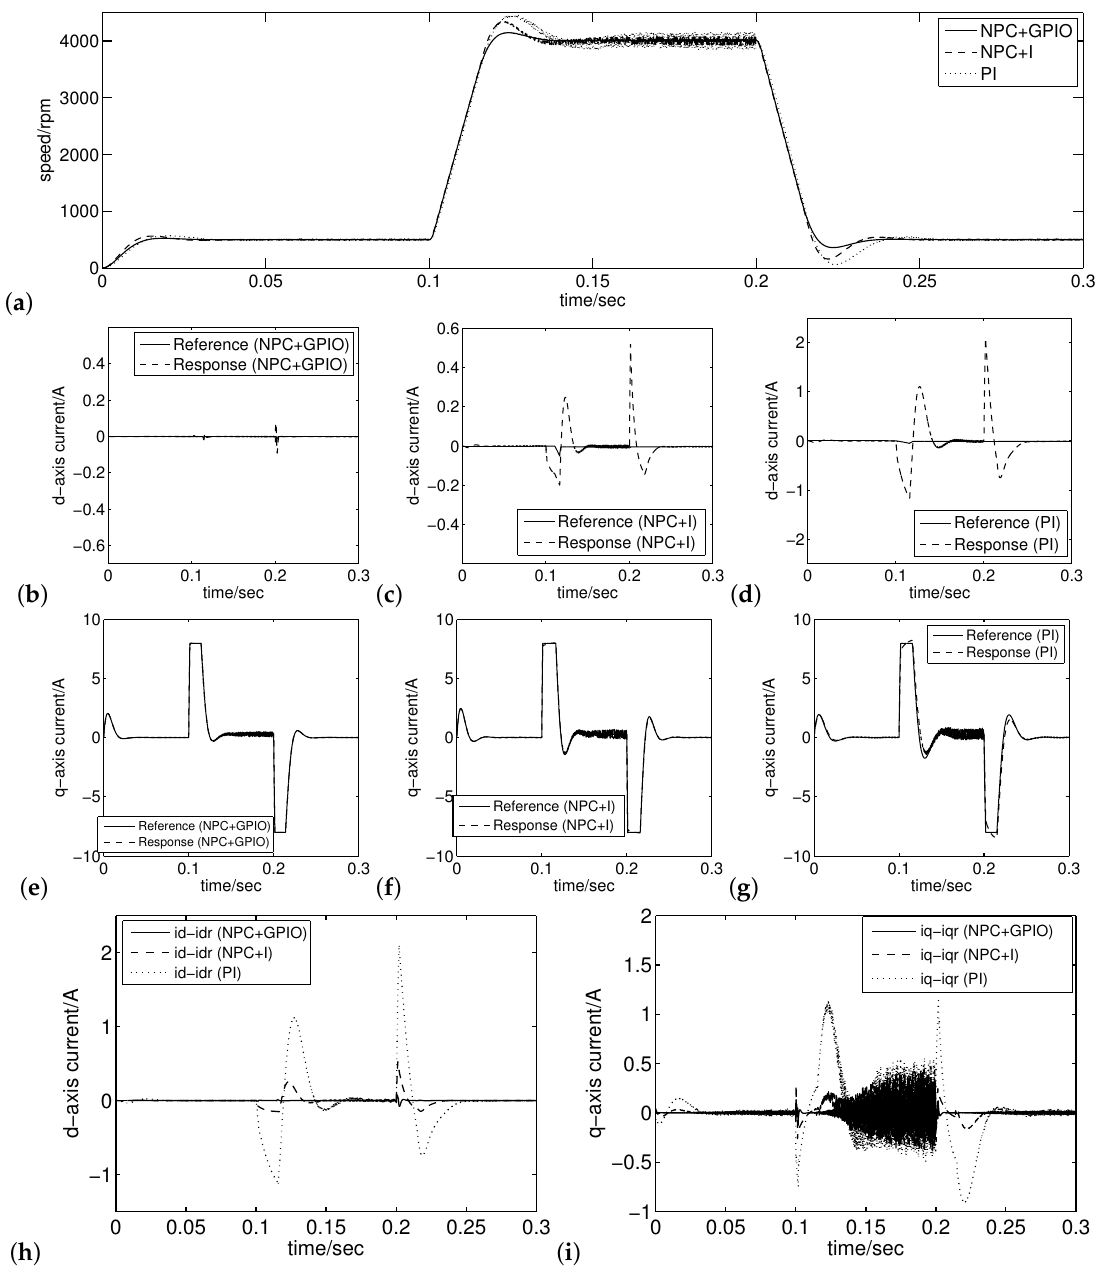
Figure 10. Speed and current responses with operation speed at 500 rpm–4000 rpm–500rpm under the same speed controller (PI) and the different current controllers (the proposed controller (NPC + GPIO), the integral controller (NPC + I) and the improved PI controller): ( a ) speed responses; ( b ) d-axis current response under the proposed controller; ( c ) d-axis current response under the integral controller; ( d ) d-axis current response under the PI controller; ( e ) q-axis current response under the proposed controller; ( f ) q-axis current response under the integral controller; ( g ) q-axis current response under the PI controller; ( h ) d-axis current-tracking errors under the different current controllers (the d-axis response current (id) minus the d-axis reference current (idr)); ( i ) q-axis current-tracking errors under the different current controllers (the q-axis response current (iq) minus the q-axis reference current